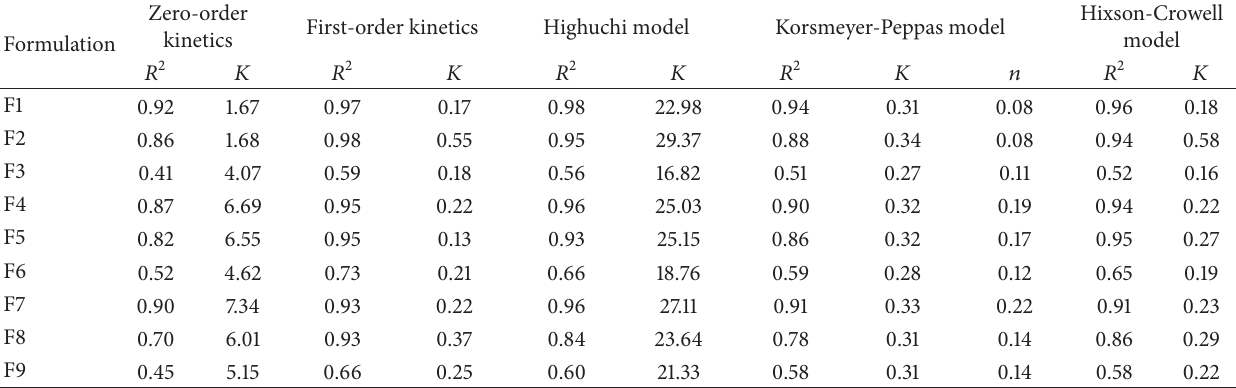
Table 3: Models of MF release from microspheres formulations F1–F9.